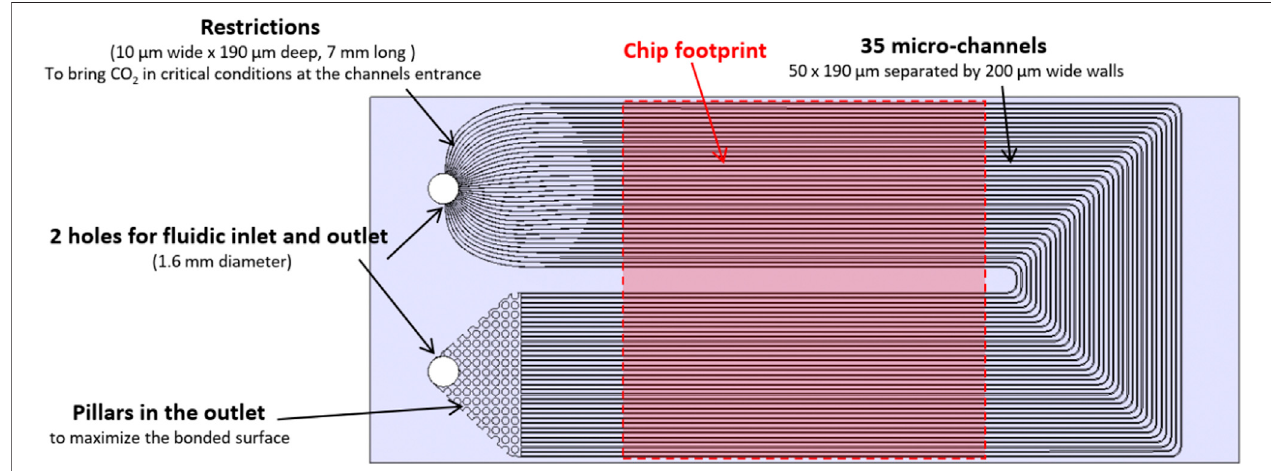
FIGURE 2 | Plan of the 2 × 4-cm 2 microchannel device, conceived for operation with evaporative CO 2 fl ows showing the 35 parallel channels, 50 × 190 µm squared, separated by 200 µm wide walls, which are fed through restrictions from a single inlet manifold visible on the top left. They have a “ C- shape ” to reach a common outlet manifold located on the same side of the inlet one and visible on the bottom left. Both inlet and outlet holes have a 16 mm diameter.